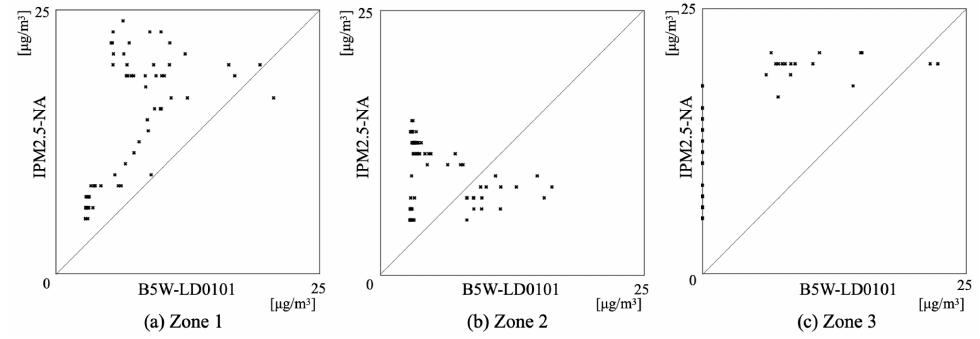
Figure 16. Scatter plots between output signals of IPM2.5-NA and B5W-LD0101 in the respec- tive